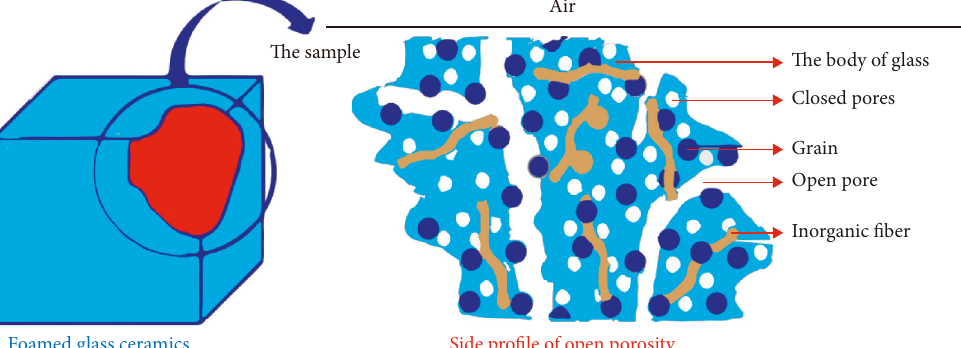
Figure 1: Schematic diagram of the preparation of porous foam glass-ceramic composite building thermal insulation material by the foaming method.